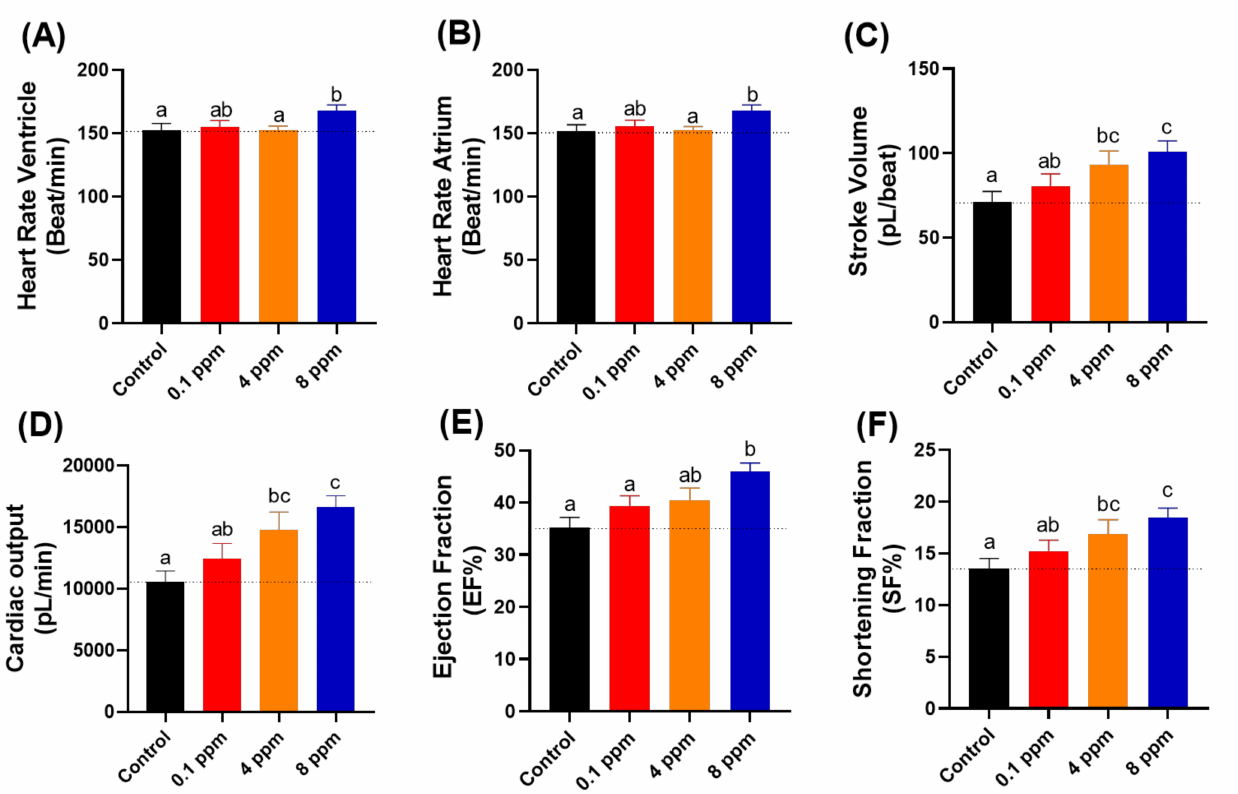
Figure 3. Cardiac physiology analysis of zebrafish larvae at 72 hpf after exposed to different doses of RAC. Several important parameters like ( A ) heart rate in the ventricle, ( B ) heart rate in the atrium, ( C ) stroke volume, ( D ) cardiac output, ( E ) ejection fraction and ( F ) shortening fraction were measured and compared. The data are expressed as the means ± SEM and were analyzed by one-way ANOVA test followed with Fisher’s LSD test. Different letters a, b, and c above columns indicate significant statistical differences with p < 0.05 ( n = 27 for all groups). Black bar: control, red bar: RAC 0.1 ppm, orange bar: RAC 4 ppm, and blue bar: RAC 8